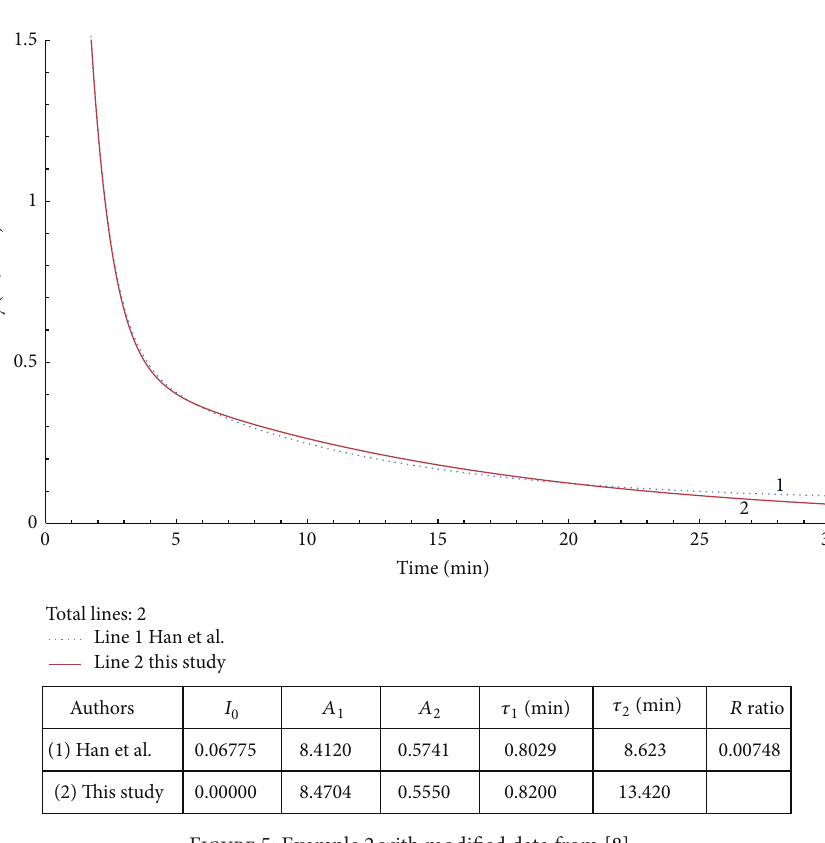
Figure 5: Example 2 with modified data from